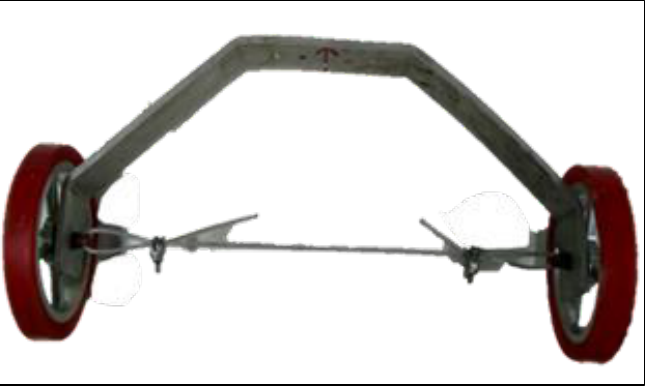
Figure 2: Current landing gear.